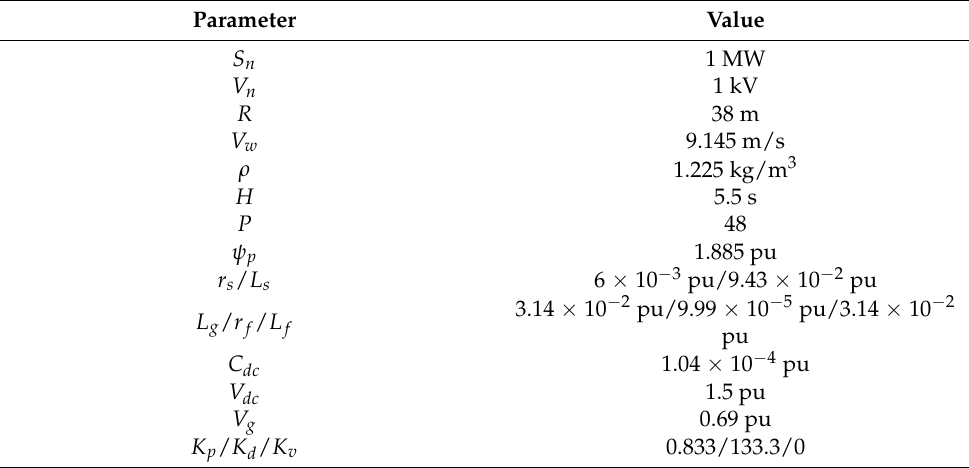
Table 3. D-PMSG parameters and settings of